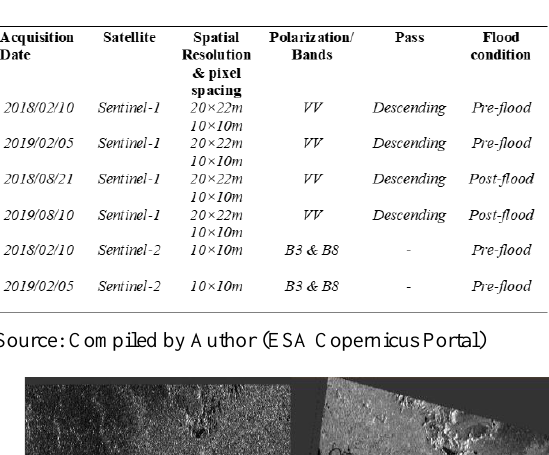
Figure 4. Pre & Post Event of Flood in 2018